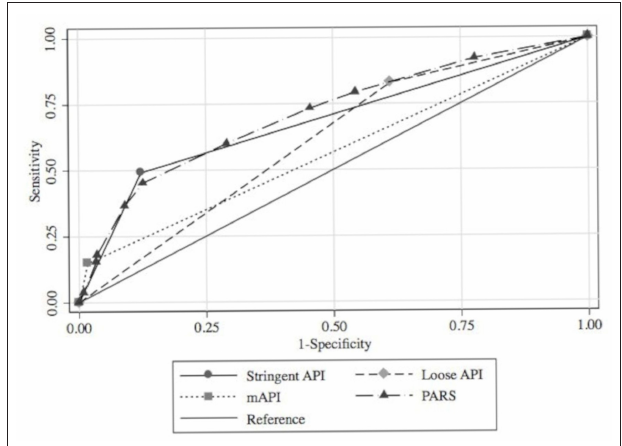
FIGURE 1 | ROC curves for four asthma prediction tools applied to children hospitalized for severe bronchiolitis during infancy (MARC-35 cohort) to predict asthma at age 5 years. MARC-35, 35th Multicenter Airway Research Collaboration; ROC, receiver operating characteristic.